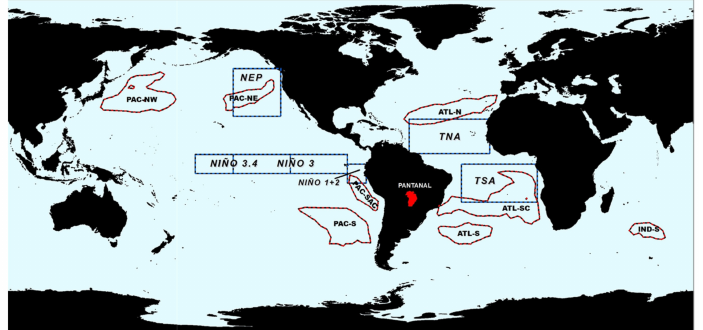
Figure 2. Oceanic regions and traditional SST indexes considered in the present study. The oceanic regions (in dashed red lines) were taken from Thielen et al. [13] and are as follows: PAC-NE — Pacific Northeast (2.7 M km 2 ), PAC-NW —Pacific Northwest (7.1 M km 2 ) and ATL-N —Atlantic North (5.2 M km 2 ), at the Northern Hemisphere; and ATL-SC —Atlantic South Central (9.0 M km 2 ), ATL-S —Atlantic South (3.2 M km 2 ), PAC-SAC —Pacific South American Coast (1.5 M km 2 ), PAC- S —Pacific South (6.5 M km 2 ), and IND-S —Indian South (1.6 M km 2 ), at the Southern Hemisphere. The traditional SST indexes (in dashed blue lines) include: NEP —Northeast Pacific (9.9 M km 2 ), TNA —Tropical North Atlantic (9.8 M km 2 ) and TSA —Tropical South Atlantic (10.1 M km 2 ); as well as the ENSO regions: NIÑO 1+2 (1.2 M km 2 ), NIÑO 3 (7.4 M km 2 ) and NIÑO 3.4 (6.2 M km 2